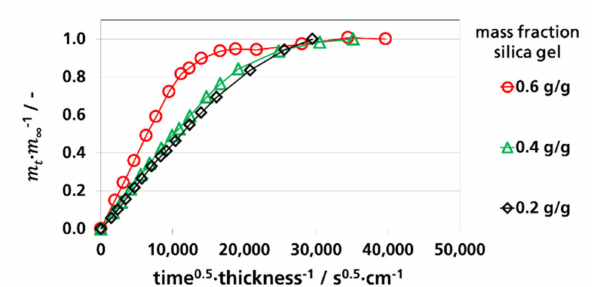
Figure 4. Water vapor absorption of films with dispersed silica gel at 52% RH and 23 ◦ C, determination of D ef f